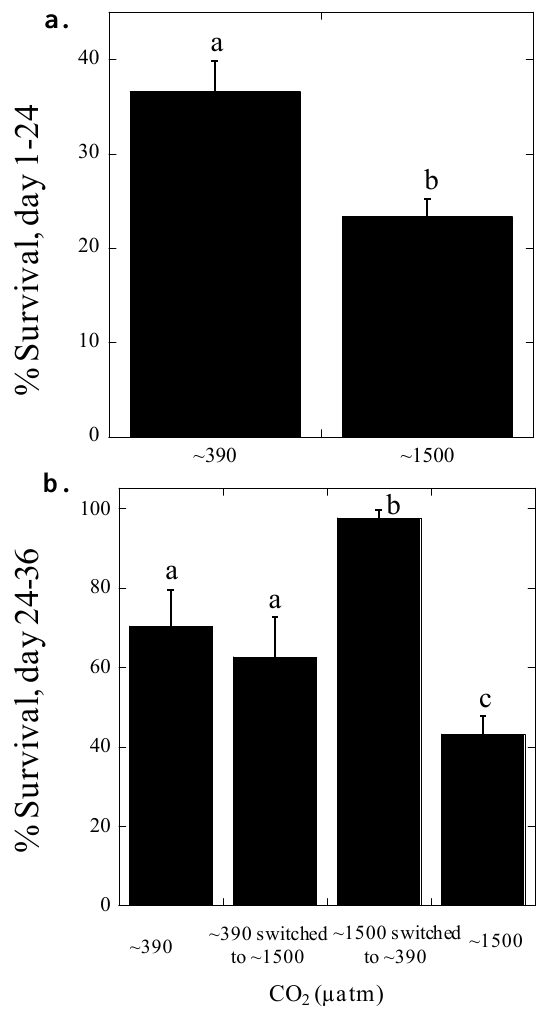
Fig. 5. (a) Percent survival of Mercenaria mercenaria exposed to 390, and 1500µatm CO 2 during larval development (Table 5). (b) Percent survival of post-set, juvenile M. mercenaria under four treatments of CO 2 : individuals exposed to 390µatm since fertil- ization; individuals exposed to 390µatm as larvae and increased to 1500 at day 24; individuals exposed to 1500µatm as larvae and de- creased to 390µatm at day 24; and individuals exposed to 1500µatm since fertilization. Values are means ± 1SD; n = 4 per treatment. Letters indicate significant differences revealed from Tukey post hoc multiple comparisons, p ≤ 0 . 05 for